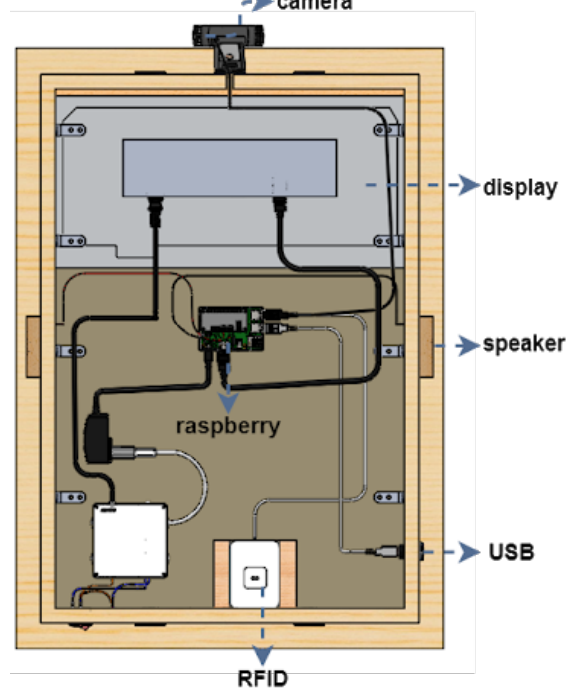
Figure 4. Component positioning at the back of the smart mirror